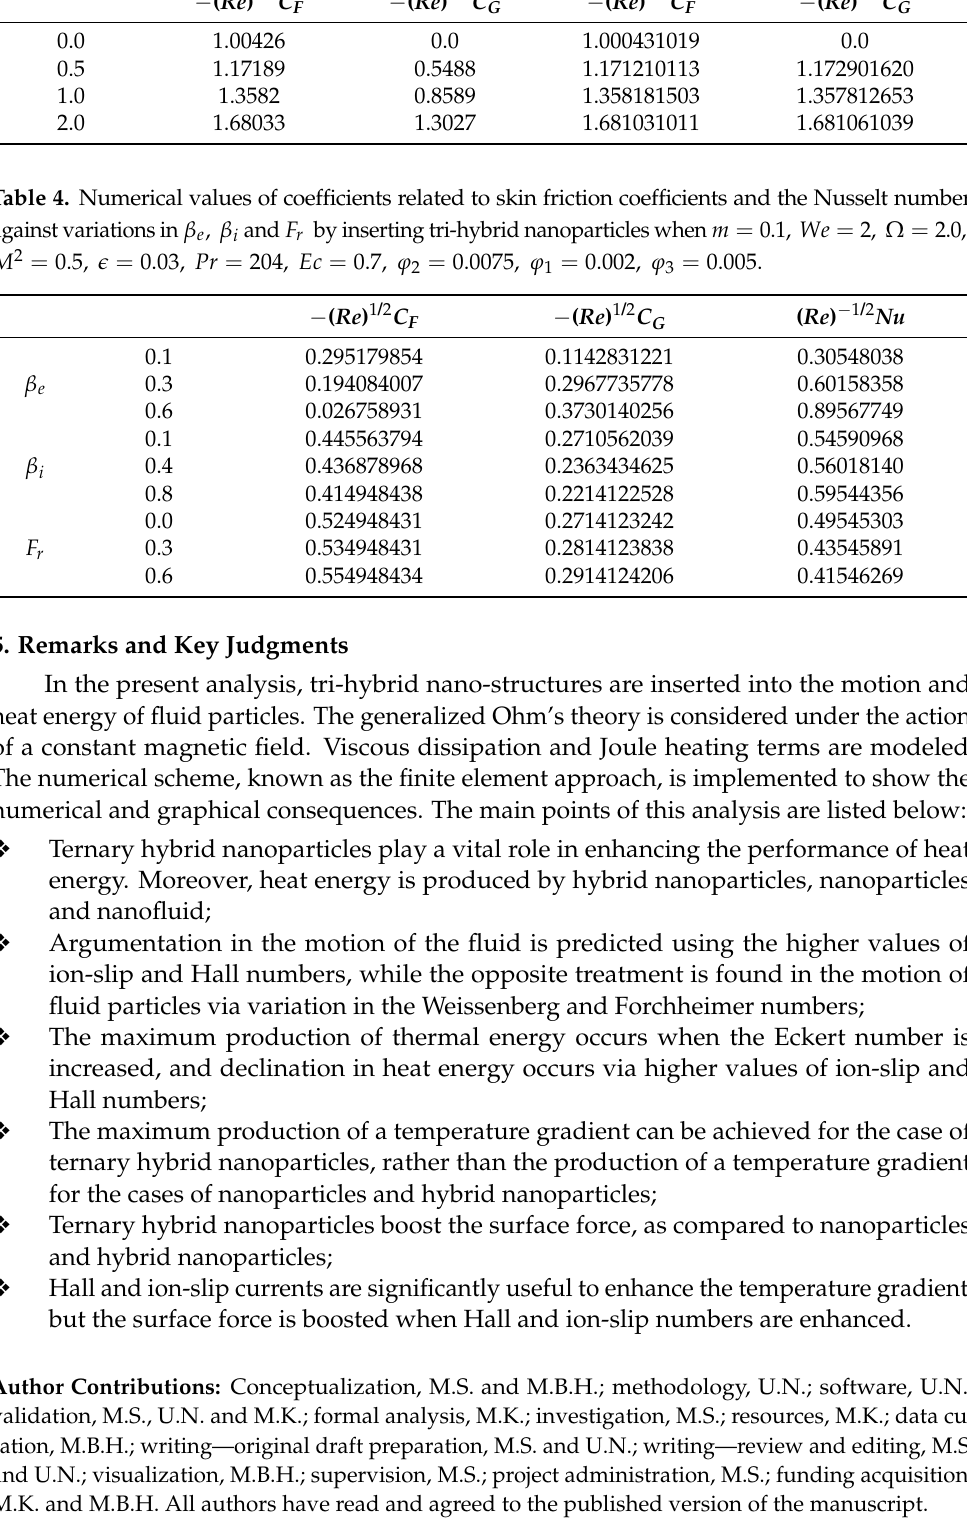
Table 3. Comparative results of skin friction coefficients when m = 0.0, We = 0.0, M 2 = 0.0, β e = 0.0, β i = 0.0, (cid:101) = 0.0, F r = 0.0, Pr = 2.04, Ec = 2.0, ϕ 2 = 0.0, ϕ 1 = 0.0, ϕ 3 = 0.0. Ω .